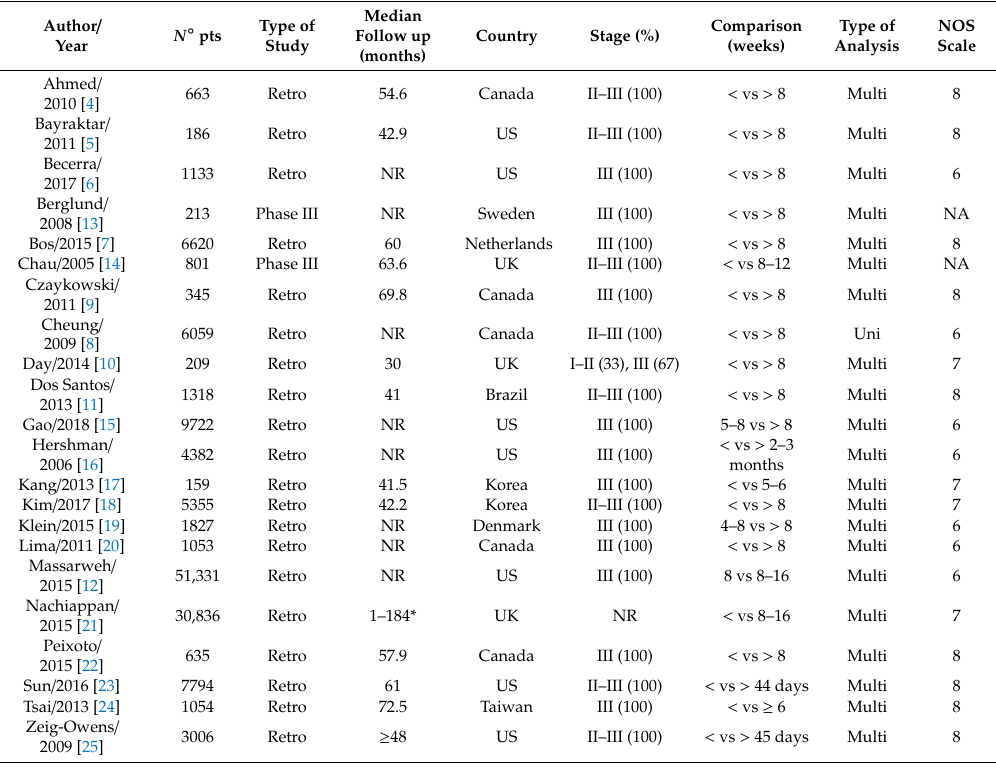
Table 1. Characteristics of included studies for colorectal